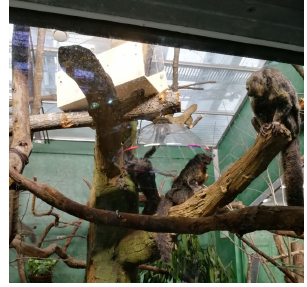
Figure 2. The prototypes in the